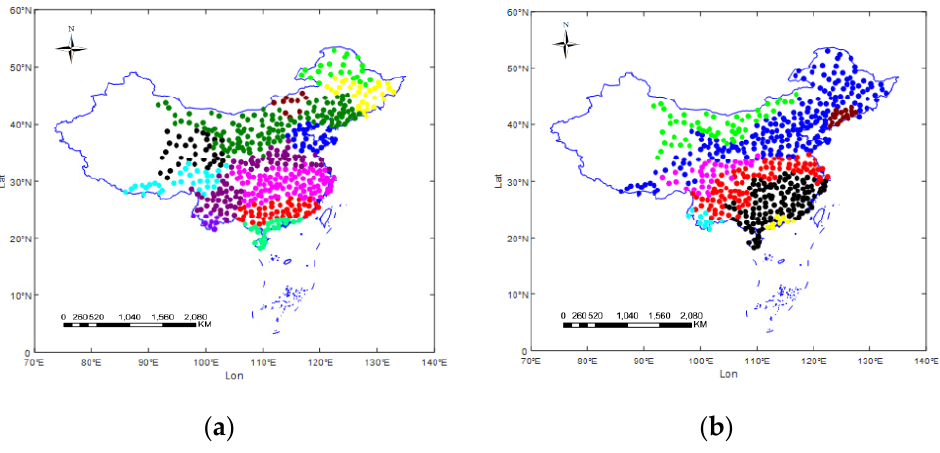
Figure 5. Homogenous sub ‐ regions of ( a ) temperature and ( b ) precipitation.